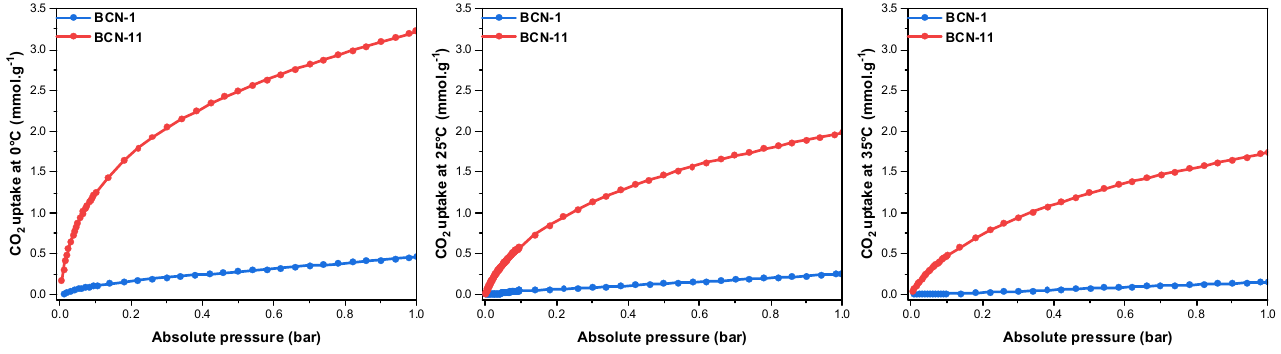
Figure 6. CO 2 uptakes of BCN samples at 0 ◦ C, 25 ◦ C and 35 ◦ C. Table 3. CO 2 uptake performances of the studied materials at 1 bar.